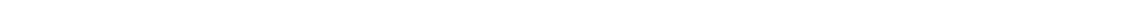
experiment using a high vector dose (1 × 10 12 vg per vector and mouse) injected into 15 weeks-old C57BL/6 male mice ( n = 3). Mice were sacri fi ced upon appearance of palpable teratomas at week 6 post-injection. f Repeat of experiment from panel e , using a scAAV8 vector encoding GFP instead of c-Myc ( n = 3). All three mice were sacri fi ced at month 12 post-injection. One mouse (Supplementary Table 5, mouse #1, assay #6) had a teratoma (yellow arrowhead) in the pancreas. g Histological sections of teratomas (extracted 8 weeks post-injection) from mice injected with a cocktail of scAAV8 vectors encoding hCO-O/K/S/M or TTR promoter-driven Cre recombinase ( n = 3). Sections were stained with hematoxylin/eosin and an anti- β -galactosidase (left) or anti-Oct-3/4 antibody (right). Scale bars = 200 µ m. This fi gure contains elements from Servier Medical Art